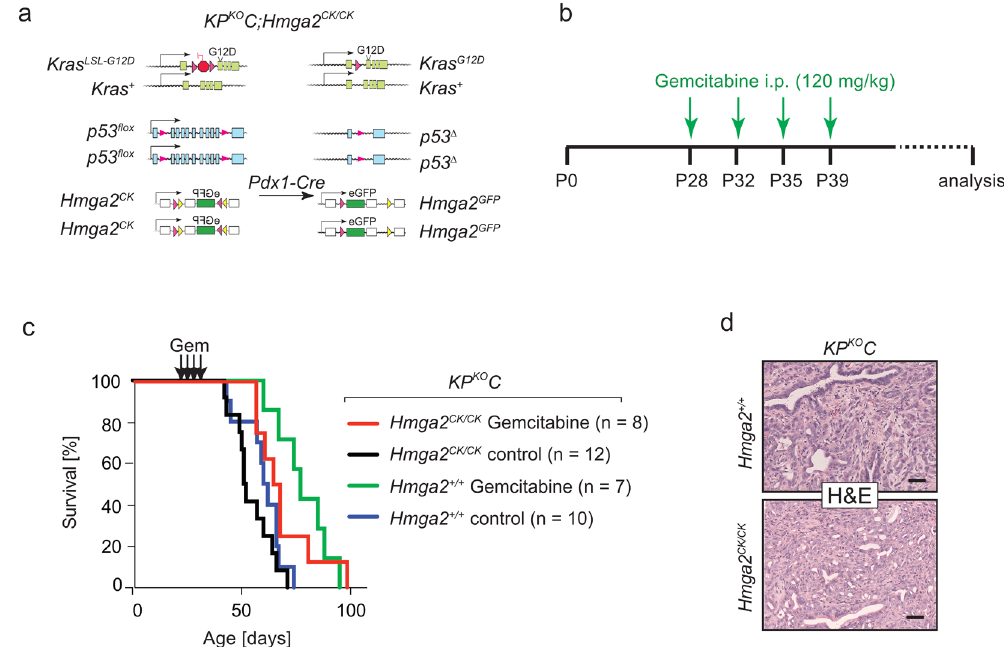
Figure 3. Hmga2 deficiency does not dramatically alter PDAC sensitivity to gemcitabine. ( a–c ) KP KO C;Hmga2 + / + and KP KO C;Hmga2 CK/CK mice ( a ) were treated with four intraperitoneal gemcitabine injections at 28, 32, 35, and 39 days of age ( b ) and compared to their respective vehicle-treated control littermates. Gemcitabine treatment slightly increased median survival in both genotypes (65.5 days in KP KO C;Hmga2 CK/CK and 77 days in KP KO C;Hmga2 + / + mice) compared to untreated controls (51.5 days in KP KO C;Hmga2 CK/CK and 61 days in KP KO C;Hmga2 + / + mice), but no significant survival difference was observed between gemcitabine -treated KP KO C;Hmga2 CK/CK and KP KO C;Hmga2 + / + mice ( p = 0.47) ( c ). ( d ) Representative histology of tumours in KP KO C;Hmga2 + / + and KP KO C;Hmga2 CK/CK mice treated with gemcitabine. Across all mice, no consistent changes in histology were observed. Scale bars = 50 µ